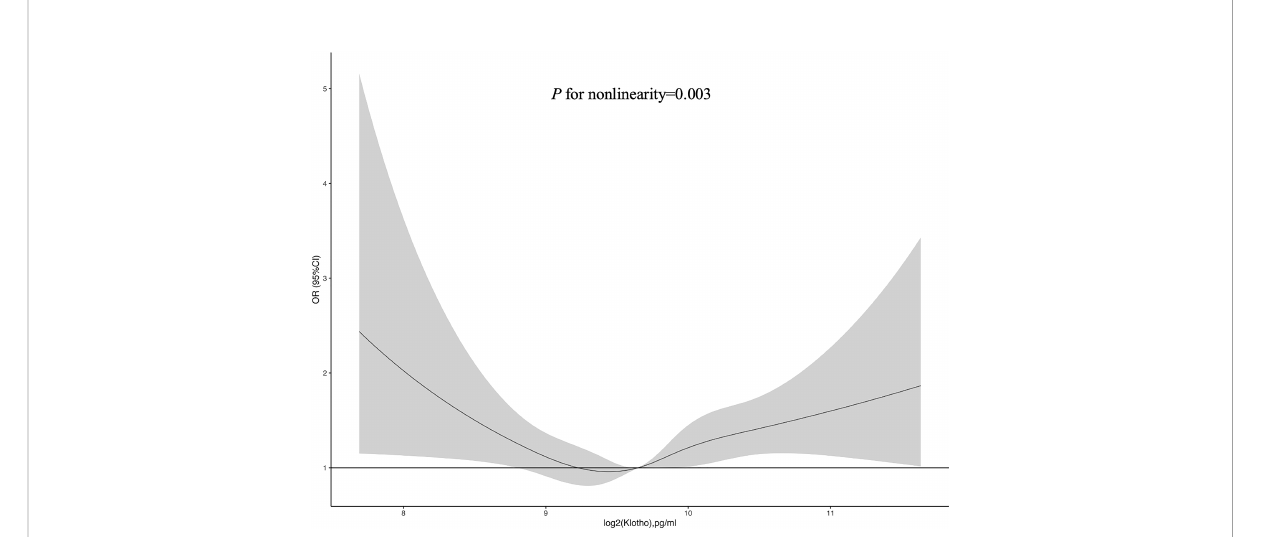
FIGURE 2 Restricted cubic spline of the association between serum Klotho and diabetes. The association was adjusted for age, sex, educational level, race, BMI, waist circumference, smoking status, alcohol intake, physical activity, CVD, hypertension, dyslipidemia, total cholesterol, LDL-C, HDL-C, triglyceride, and eGFR. The median log2-transformed serum Klotho level was chosen as a reference. Abbreviations: BMI, body mass index; CVD, cardiovascular disease; DM, diabetes mellitus; LDL-C, Low-Density Lipoprotein Cholesterol; HDL-C, High density leptin cholesterol; eGFR, estimated glomerular fi ltration